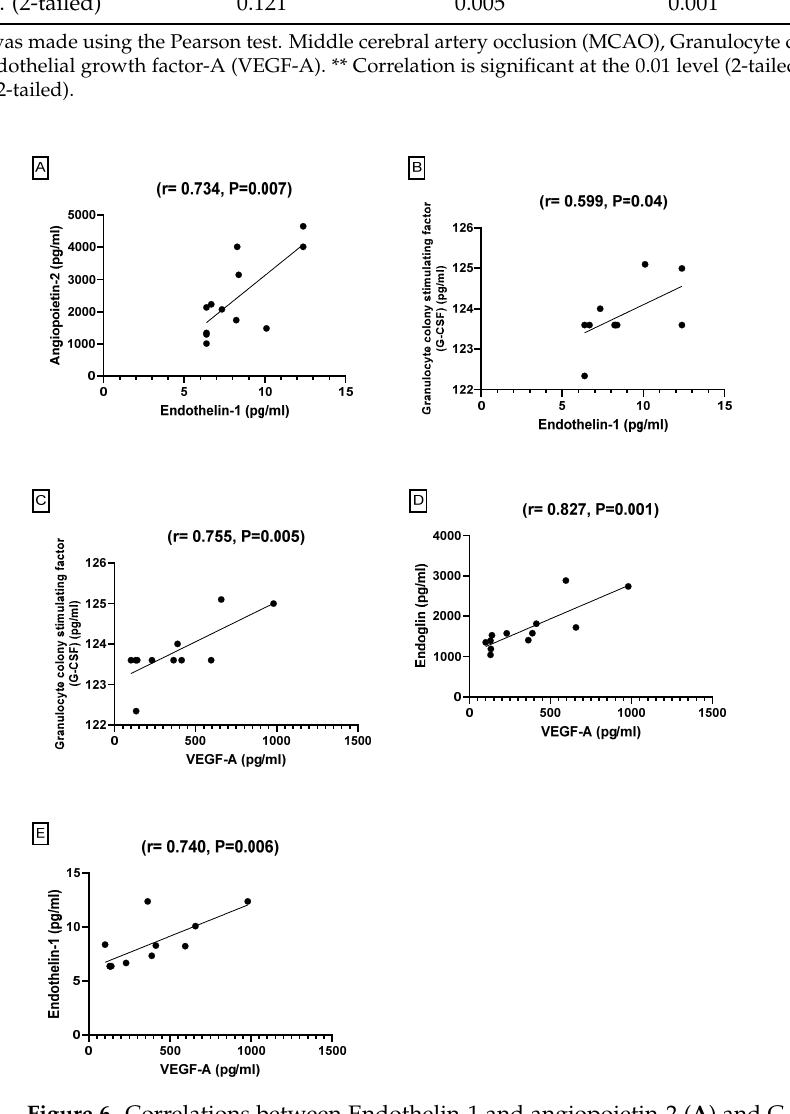
Figure 6. Correlations between Endothelin-1 and angiopoietin-2 ( A ) and G-CSF ( B ). Correlations between VEGF-A and Endothelin-1 ( C ), endoglin ( E ), G-CSF and ( D ).